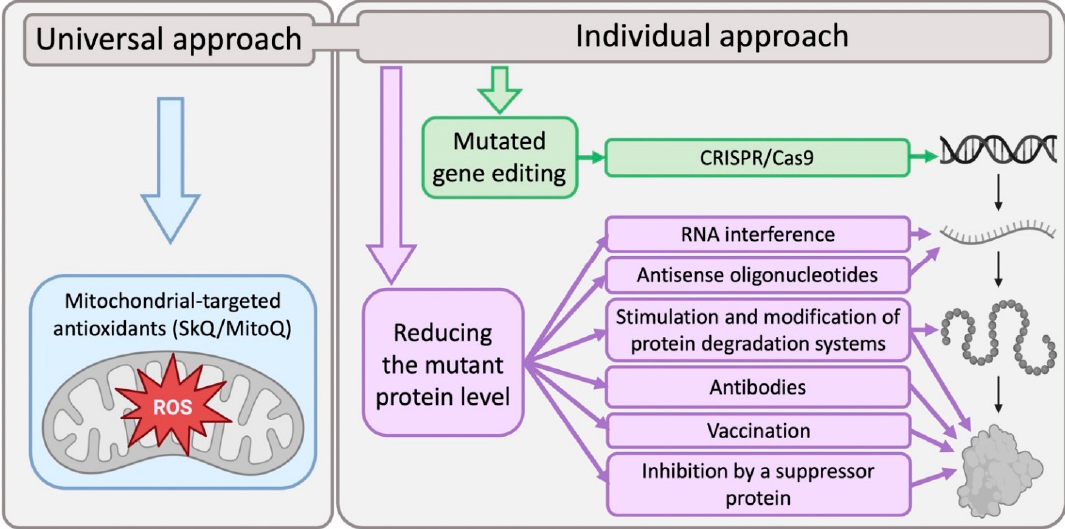
Figure 3. The proposed strategy to the neurodegenerative diseases treatment. The most promising strategy looks at a combination of universal mitochondrial therapy and one of the innovative individ- ual approaches for each disease. Figure was created with BioRender.com (accessed on 25 October